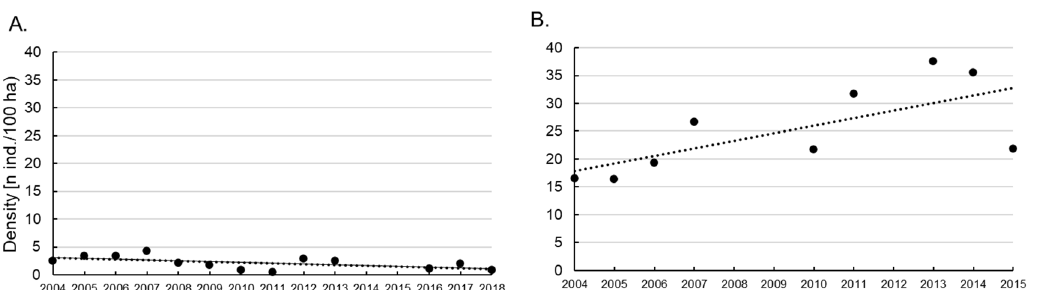
Figure 6. Comparison of brown hare densities between ( A ) the study area (Rogów) and ( B ) a reference area placed in central Poland (Dobieszyn). The method of spotlight counts along transect routes, in open fields, in the autumn/winter period was used.